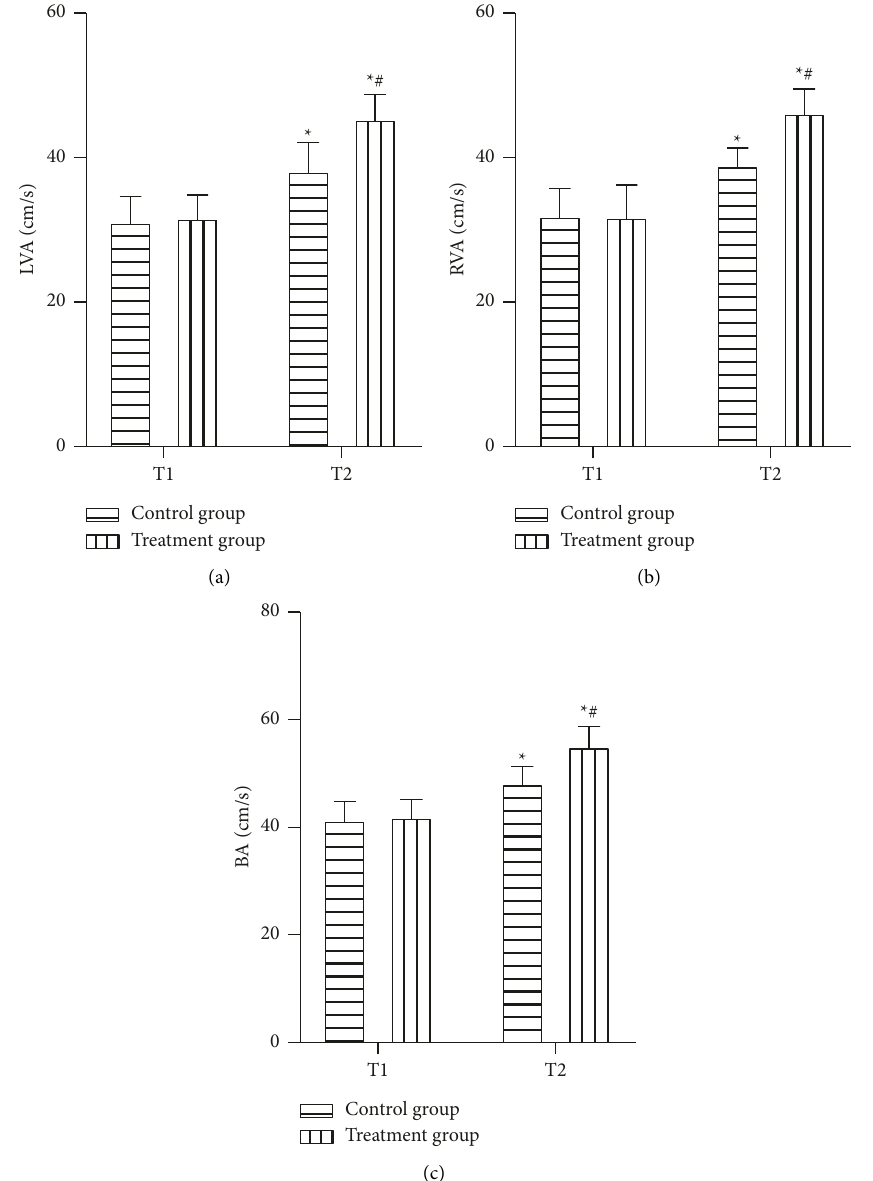
Figure 5: (a) LVA, (b) RVA, and (c) BA. ∗ indicates a significant difference ( P < 0 . 05) between each group compared with the same group at T1. # indicates significant difference ( P < 0 . 05) between the 2 groups at